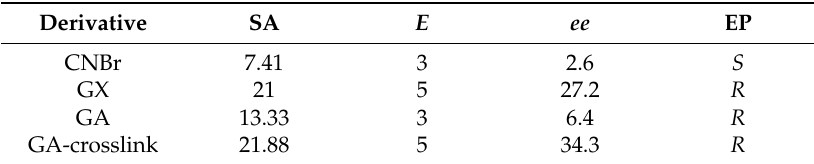
Table 4. Activity and enantioselectivity of lipase derivatives in the hydrolysis of racemic -2-hydroxy- 4-phenylbutanoic acid ethyl ester.